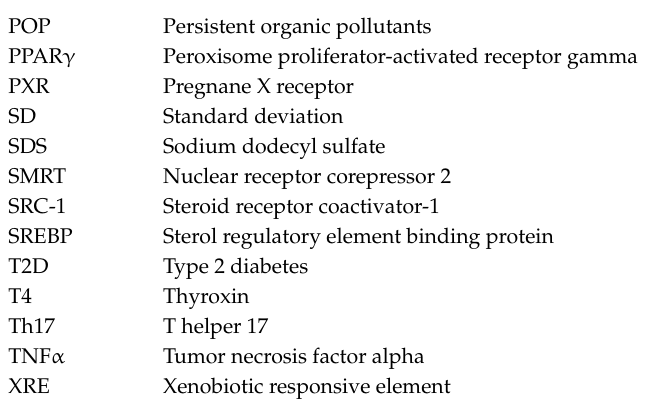
Table A1. Intergroup comparison: the significance of the synergism and antagonism. Significance of differences of gene expression between assays treated with either BaP only, or with BaP + PCBs in “Time 1” and “Time 2”. The intergroup comparisons were obtained with Kruskal–Wallis test followed up by Dunn’s test. The level of significance is * p < 0.05; ** p < 0.01; *** p < 0.001; **** p < 0.0001. Genes for which there is no significant difference are indicated in italics. ns: no significant. Genes for which there is no significant difference are indicated in bold.